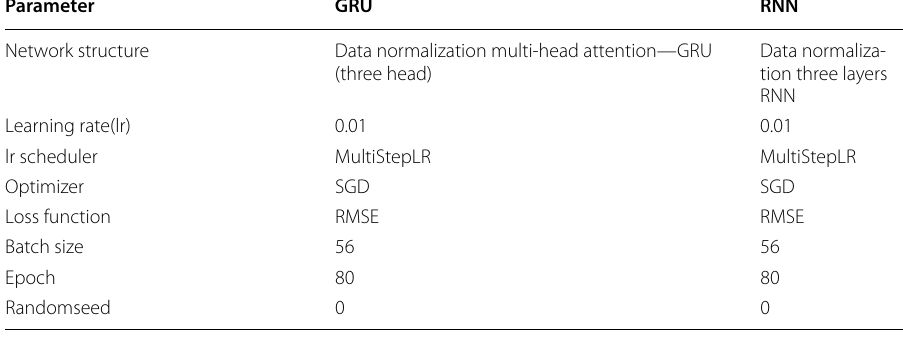
Table 1 Parameter setup for different machine learning methods Parameter GRU Network structure